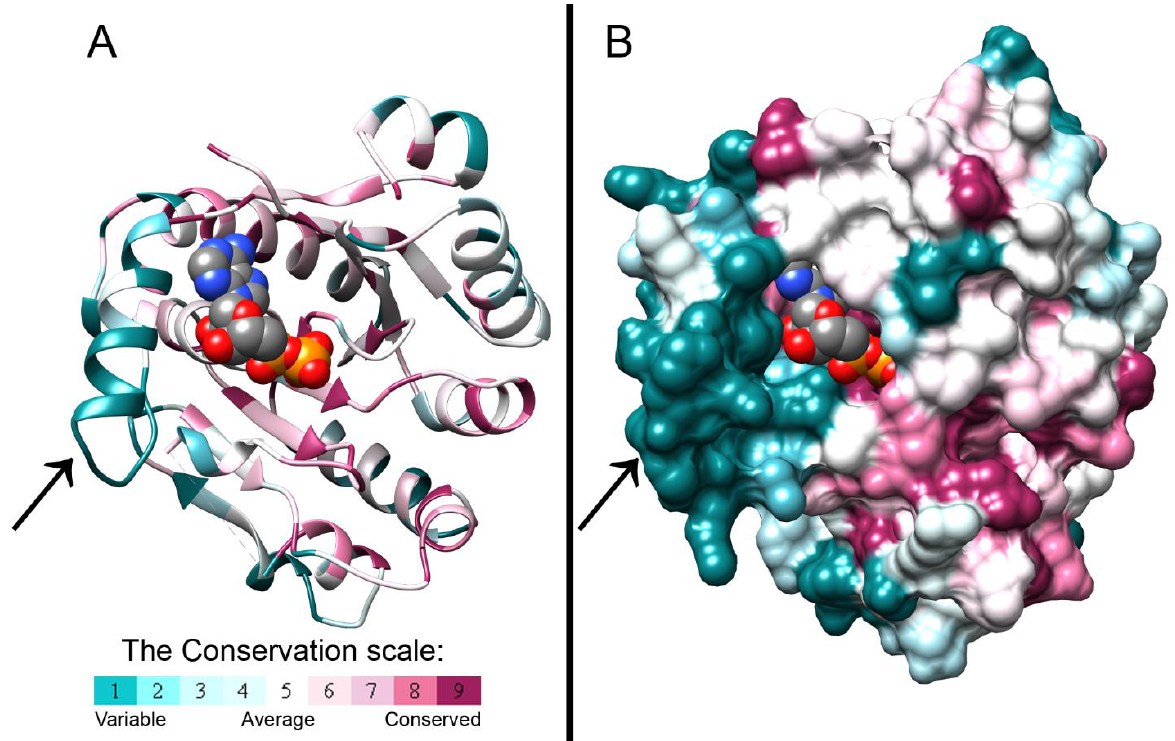
Figure 1. Evolutionary conservation scores projected on the crystal structure of the BceF kinase domain. The crystal structure of the BceF kinase domain (showing one monomer) is colored by evolutionary conservation scores calculated using the ConSurf webserver [21–23]; a variable-to-conserved colored scale is indicated. ADP bound at the active site is represented as space-filled atoms and colored by atom-type with carbons in grey, oxygen in red, nitrogen in blue, and sulfur in yellow. BceF is shown either as ribbons to indicate secondary structures ( A ) or in a solvent-accessible surface representation ( B ). An evolutionary variable helix (residues 500–511, with the exception of the conserved Gln502) and the following evolutionary variable loop (residues 512–518) close to the active site are indicated with an arrow. Table 1. Data collection and refinement statistics (molecular replacement) of BceF kinase